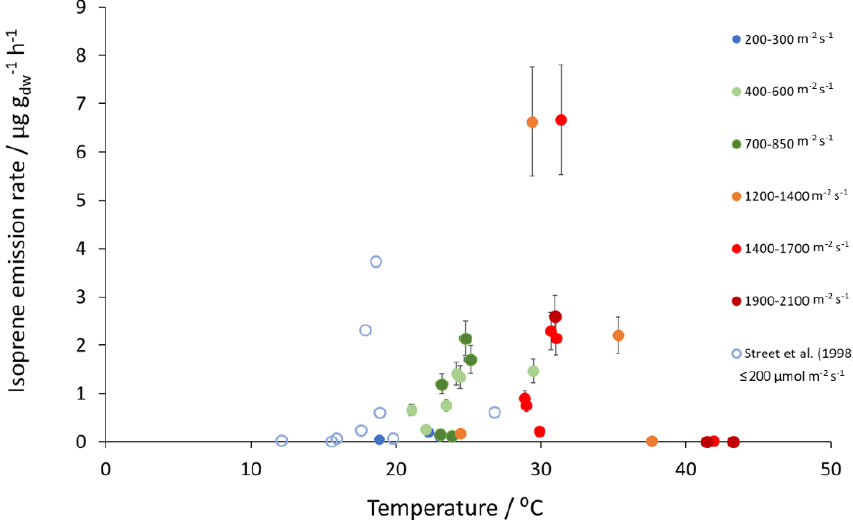
Figure 2. Measured isoprene emissions as a function of PAR and temperature for Sitka spruce at the East Grange SRF site and from Street et al. (1996) at PAR ≤ 200µmolm − 2 s − 1